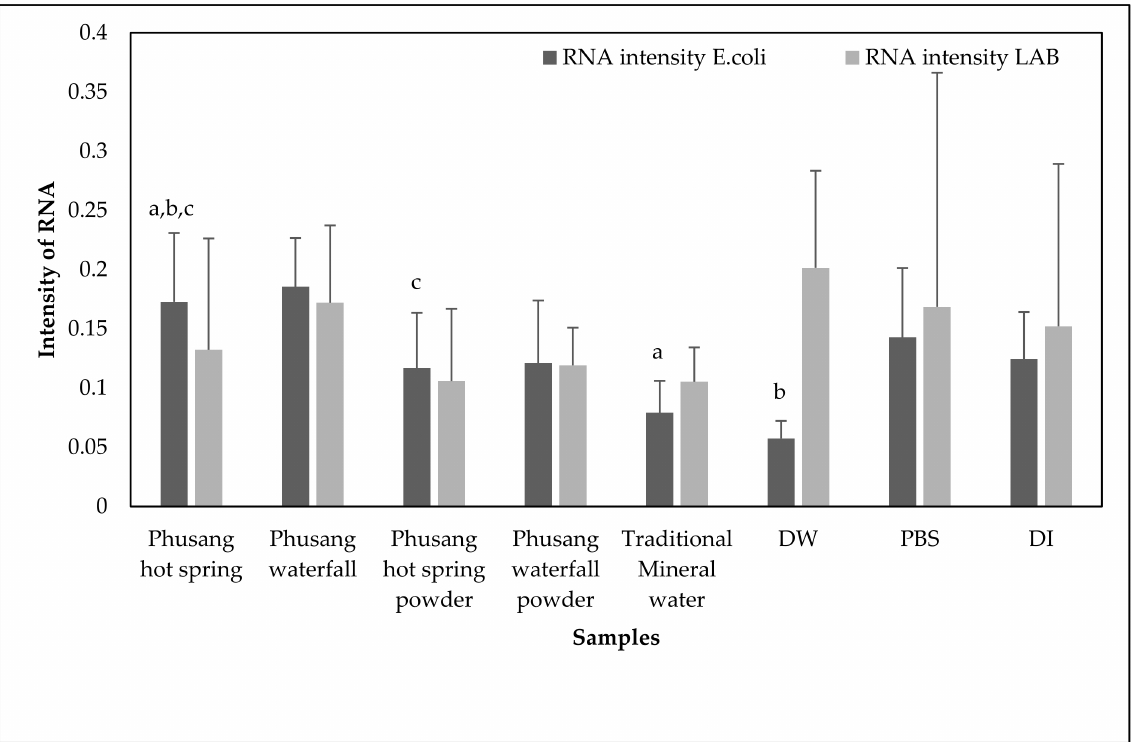
Figure 10. Differences in RNA intensity detected in E. coli and LAB cultures treated with different water samples (a, b, and c = statistically significant differences). The LAB RNA intensity in the samples was not significantly different (Figure